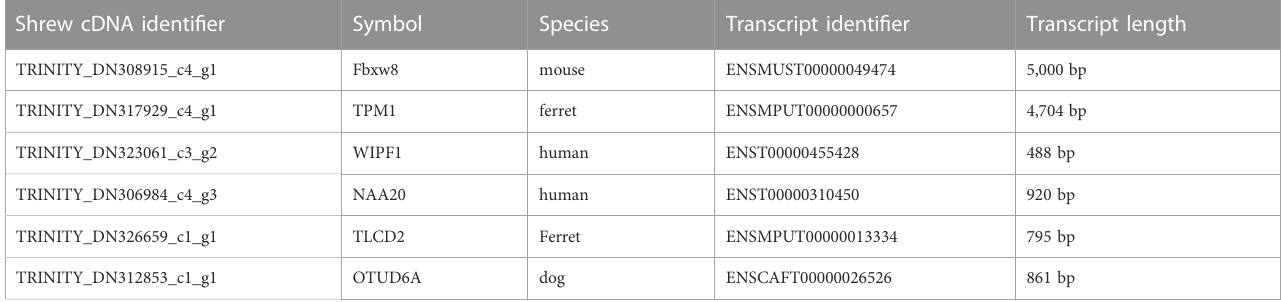
TABLE1Representativeexamplesofshrewtranscriptsequences.Asetofrepresentativeshorttranscriptsequencesidenti fi edinthesetof16,720shrewtranscripts.The corresponding orthologous sequencefrom the correspondingspecies is listedalong with the length of the sequence in that species. Gene symbols andcorresponding gene names: Fbxw8 (F-Box And WD-40 Domain-Containing Protein 8); TPM1 (Tropomyosin 1); (WIPF1) WAS/WASL-interacting protein family member 1; (NAA20) N- alpha-acetyltransferase; (TLCD2) TLC domain-containing protein 2; (OTUD6A) OTU domain-containing protein